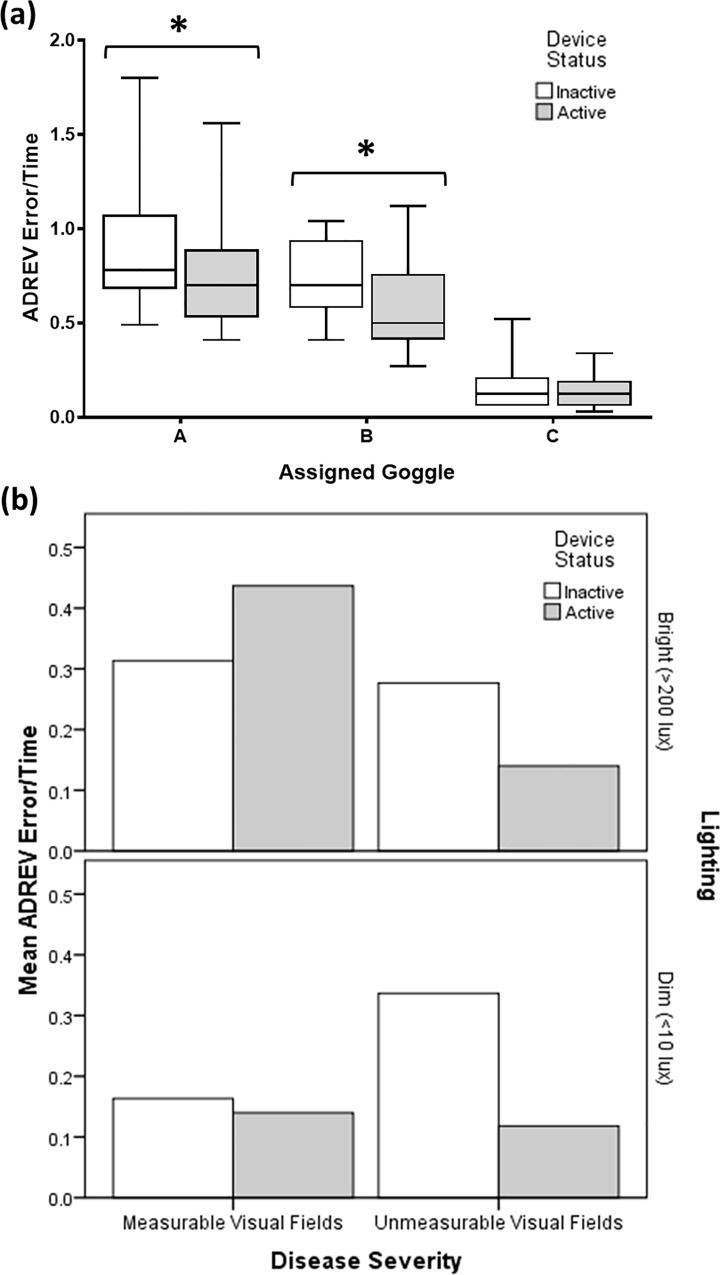
ADREV Error/Time results.Sighted subject results suggest poorer performance when using the device (grey) compared to not (white) whilst wearing goggle A (p = 0.001) and B (p = 0.005) but no change with goggle C (p = 0.944) (a). Visually impaired subjects with measurable VFs performed better with the device on average whilst those with unmeasurable VFs performed worse (b).